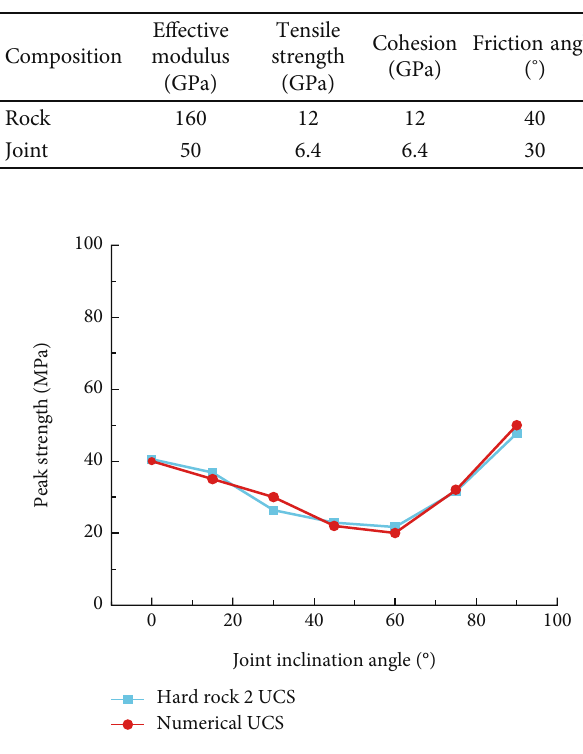
Figure 6: Relation between peak strength of rock and joint inclination angle.